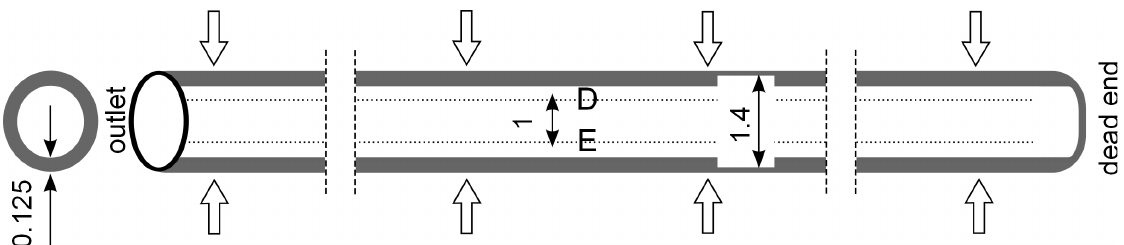
Figure 3. Positions of control lines ( D = 500 µm, E = − 500 µm) for the evaluation of velocity and particle distribution during backwash.